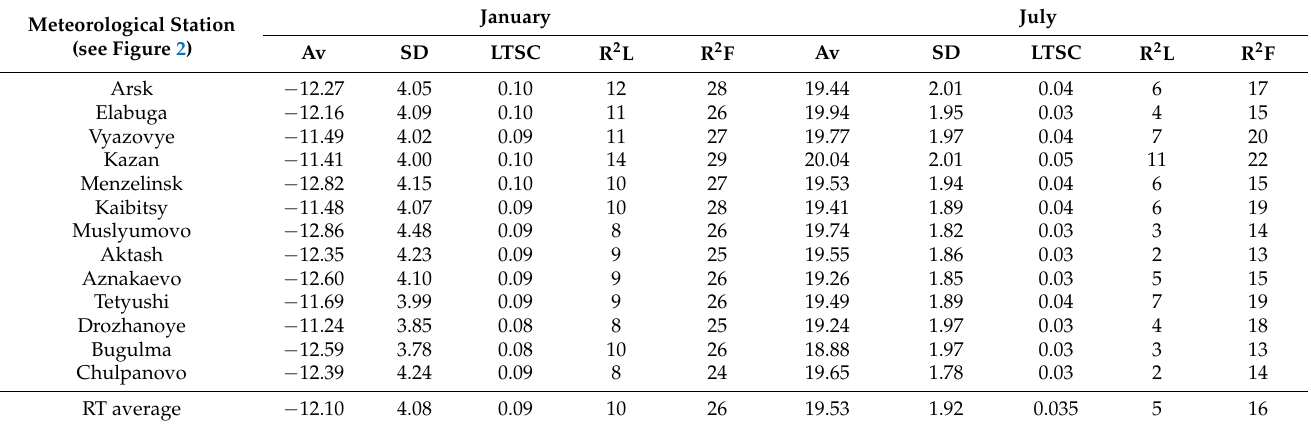
Table 7. Changes in the air temperature regime during the coldest (January) and warmest (July) months of the year in the Republic of Tatarstan (RT), the Volga Federal District, during